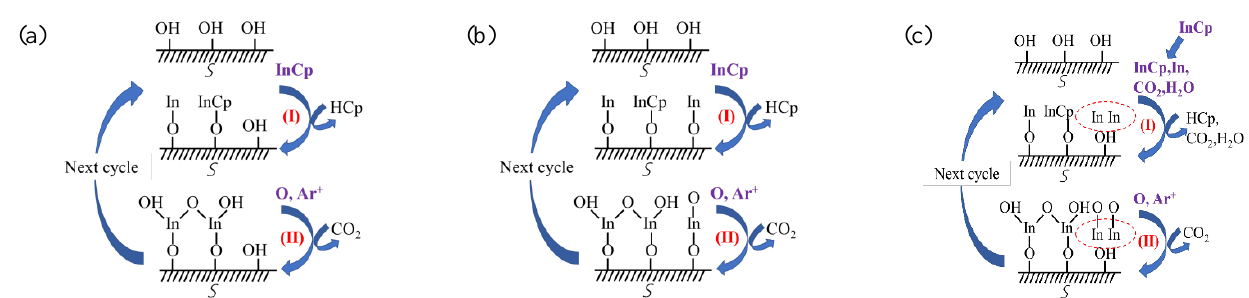
Figure 2. Deposition mechanisms of PEALD-In 2 O 3 thin film at different substrate temperatures: ( a ) the thermal activation of the adsorbed precursors at low temperature; ( b ) self-limiting reaction with saturated adsorbed precursors at intermediate temperature; and ( c ) partially thermal decomposition of the precursors at high temperature.